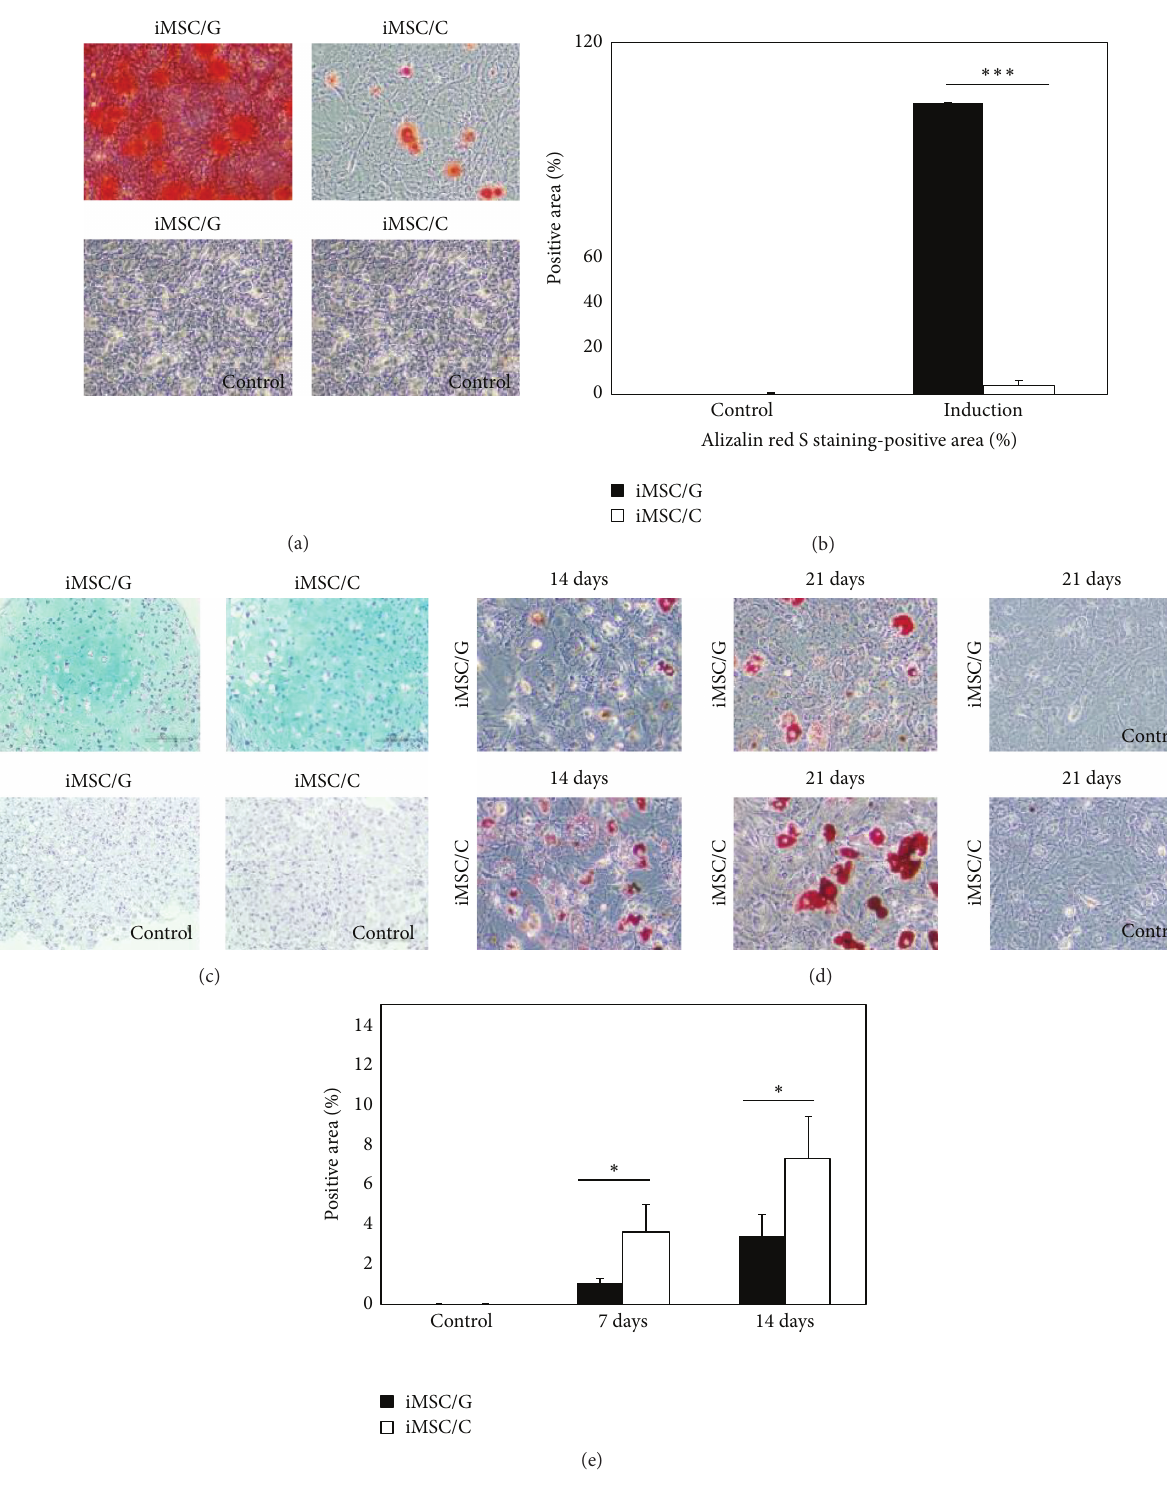
Figure 4: Osteogenic and adipose differentiation of iMSC/G and C derived from an iPSC clone (2A-4F-60). (a) iMSCs cultured in medium containing osteogenic differentiation factors (induction) or absence (control) and stained with Alizarin red at 28 days. (b) Relative amount of Alizarin red-positive areas. ∗∗∗ 𝑝 value < 0.001. (c) Chondrocyte differentiation of iMSCs by micromass culture. (d) iMSCs cultured in differentiation medium (induction) or absence (control) and stained Oil Red-O at 14 and 21 days. (e) Relative amount of Oil Red-O-positive areas. ∗ 𝑝 value <